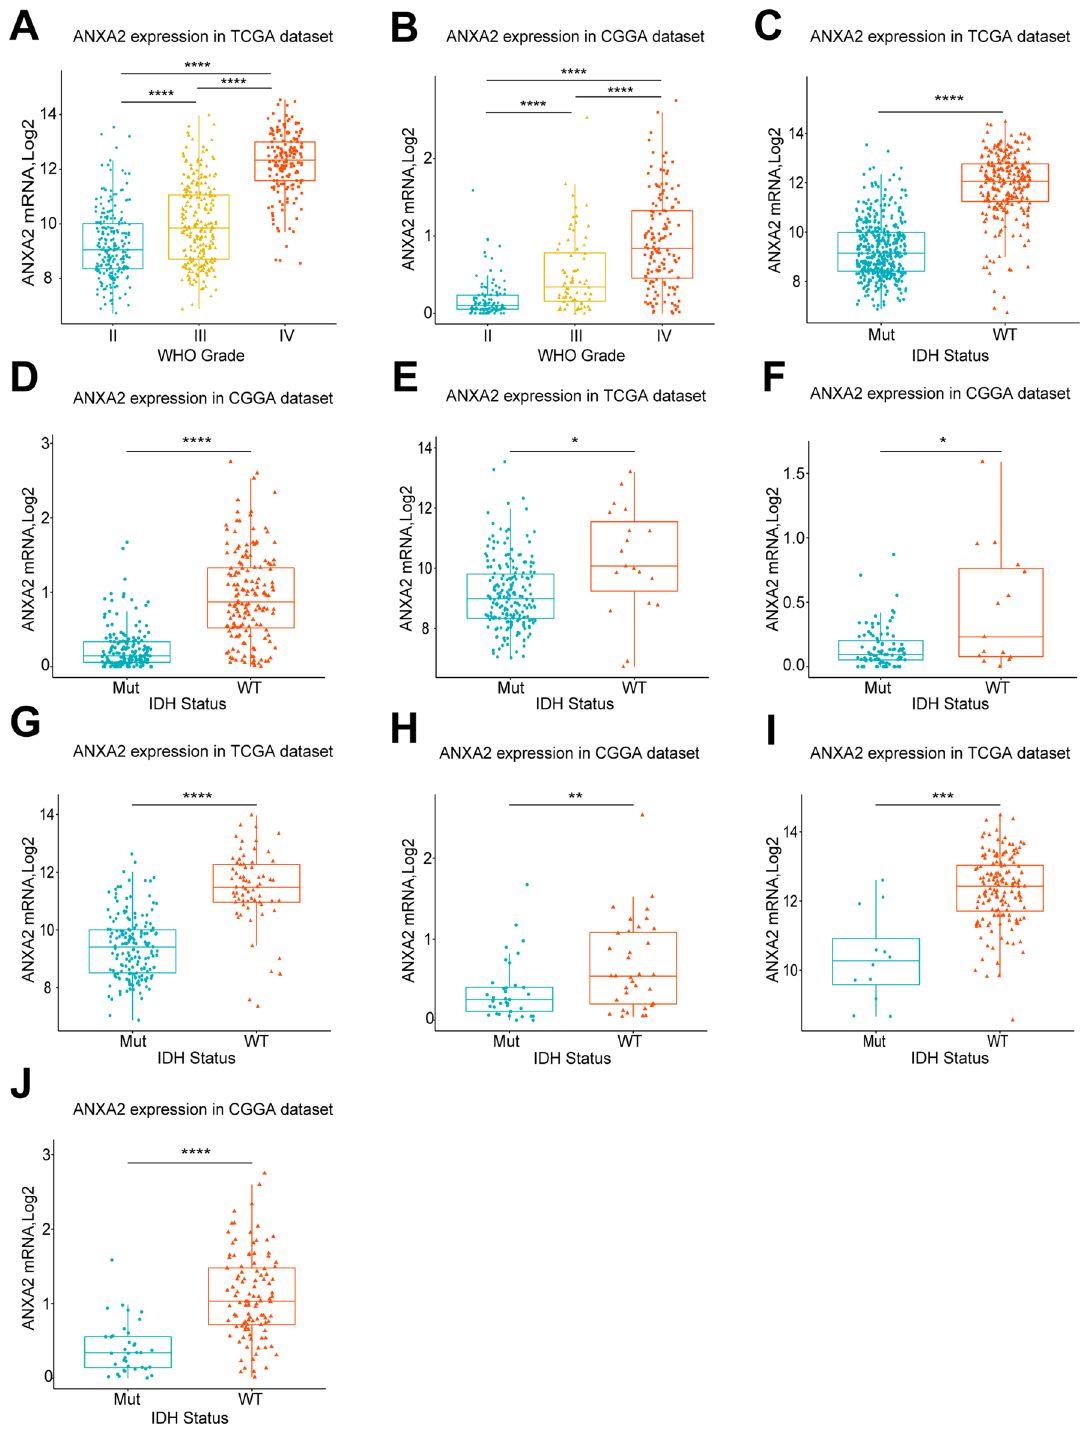
Figure 1. Comparison of the expression of ANXA2 in gliomas of different WHO grades and IDH statuses. ANXA2 was significantly highly expressed in HGG and IDH-wildtype gliomas in the TCGA and CGGA datasets. The expression of ANXA2 in the TCGA dataset according to WHO grade ( A ) and IDH status (overall WHO grades ( C ), WHO II ( E ), WHO III ( G ), WHO IV ( I )). The expression of ANXA2 in the CGGA dataset according to WHO grades ( B ) and IDH status (overall WHO grades ( D ), WHO II ( F ), WHO III ( H ), WHO IV ( J )). *P < 0.05, **P < 0.01, ***P < 0.001, **** P <